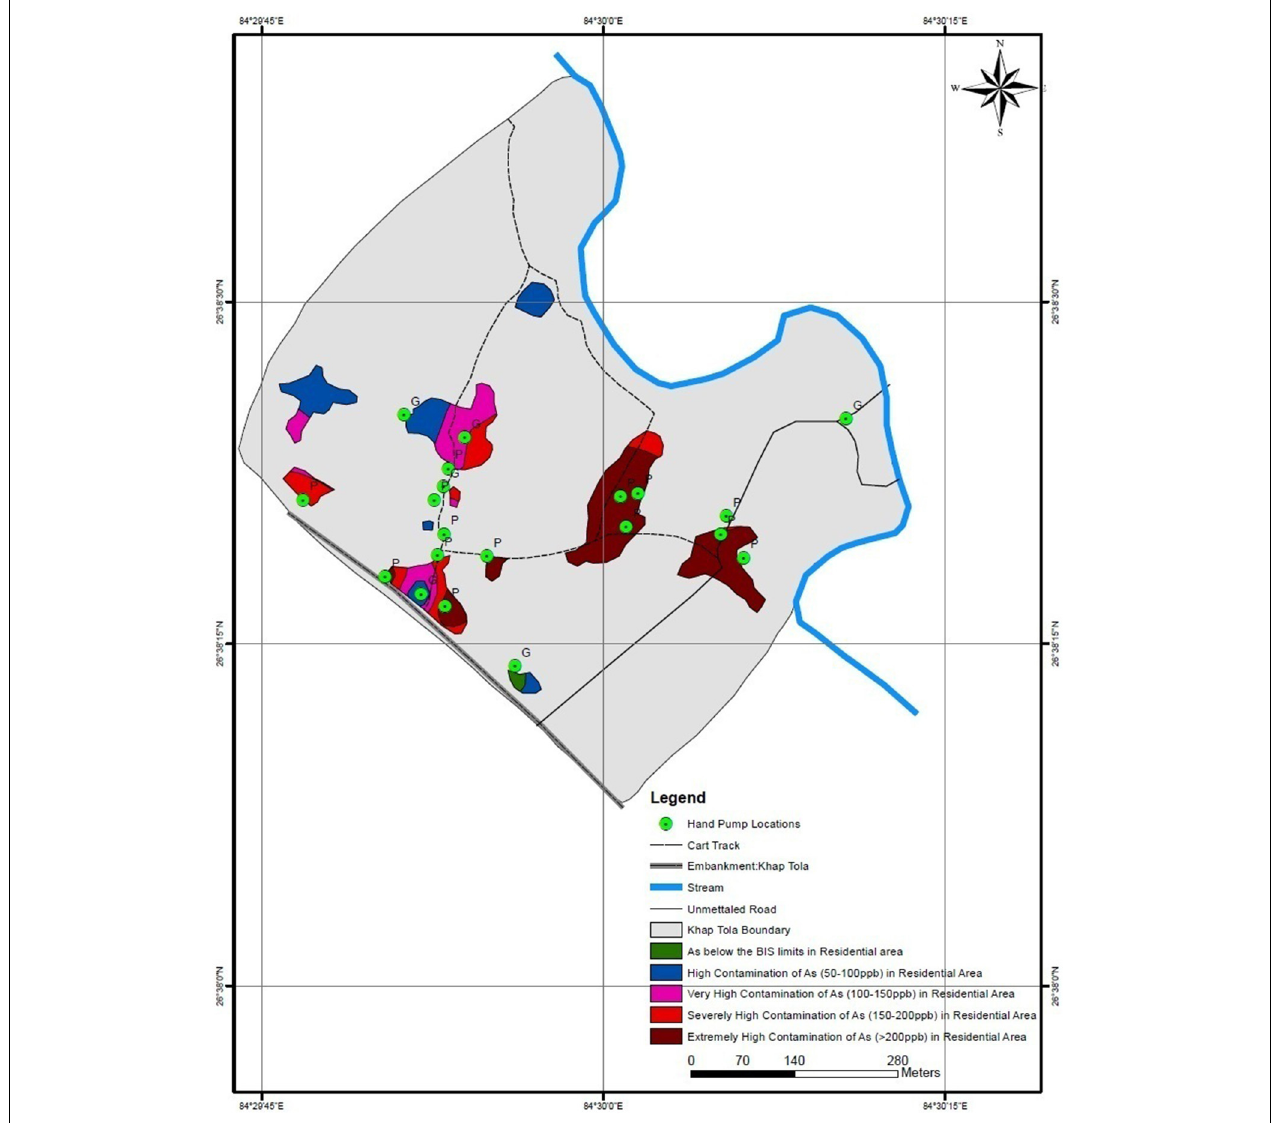
FIGURE 3 | GIS Overlay analysis of arsenic distribution in Khap Tola. The results show that maximum area of settlements 1.6 Hectares lies in the Extremely High ( > 200 ppb) zone indicating high arsenic toxicity in hand-pumps used for drinking water.